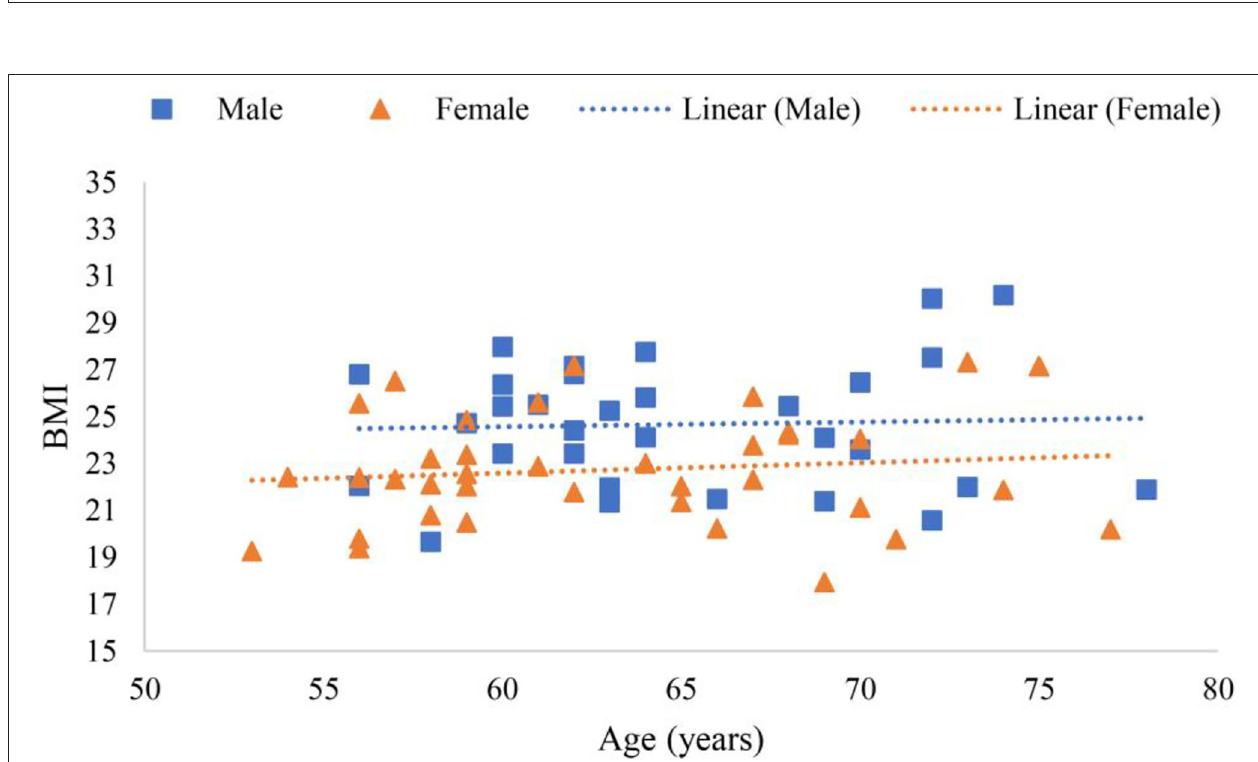
FIGURE 4 | Scatter plots of participants’ age and body mass index